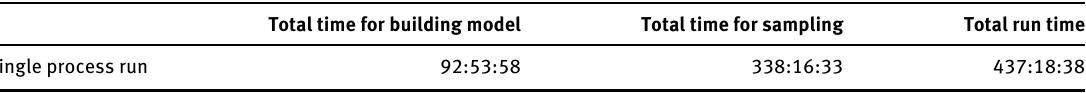
Table 1: Table with Run times for the Test Run on a single node over the complete dataset. Test run was executed on one virtual machine with 14 VCPU and 128 GB